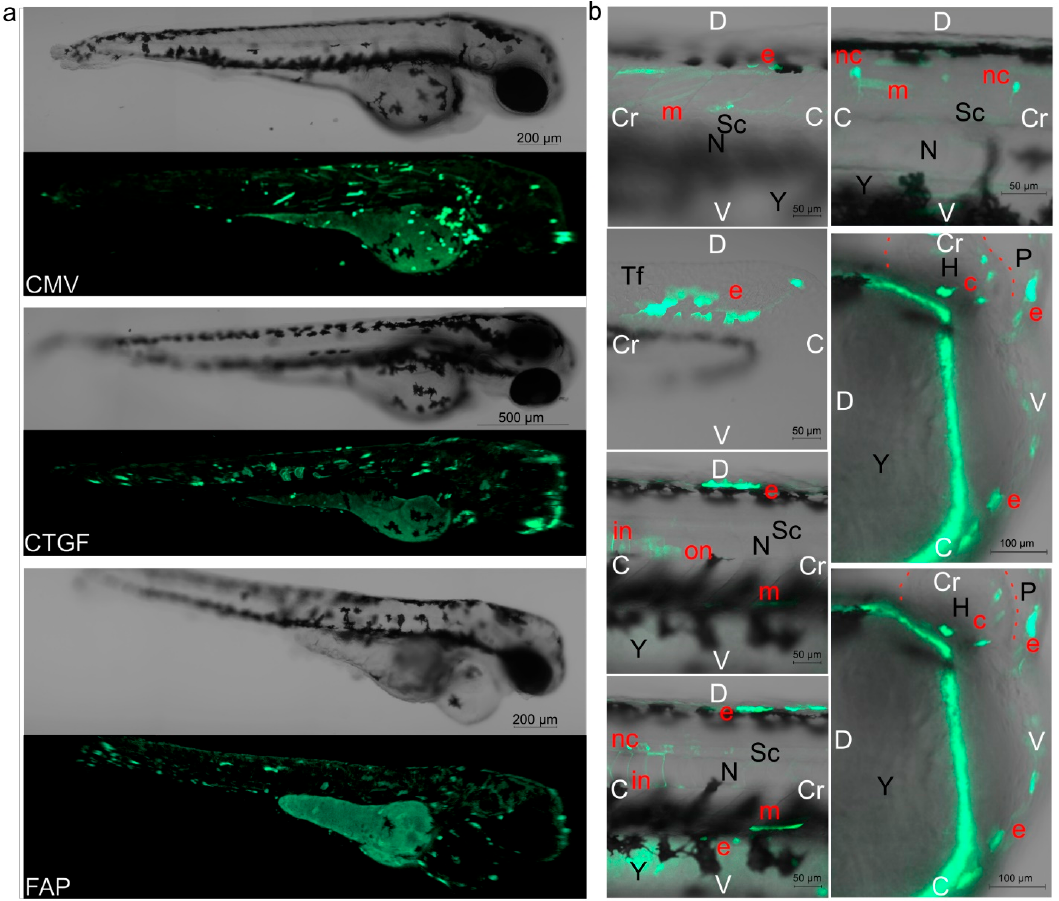
Figure 2. EGFP fluorescence in embryos, 72 h after injection. ( a ) Distribution of EGFP+ fluorescence in embryos injected with 30 attomoles of pGL3(CMV-EGFP), pGL3(CTGF-EGFP), or pGL3(FAP- EGFP). The images shown are obtained by overlaying photographs while scanning along the Z-axis. ( b ) Photographs of individual EGFP+ cells from various body parts of several embryos after injection of 30 amole pGL3(CMV-EGFP). Detailed imaging of labeled embryonic cells using FAP and CTGF promoters in vectors is not shown. White marks: Cr—cravial pole, C—caudal pole, D—dorsal pole, V—ventral pole. Black marks: N—notochord, P—pericardium, Y—yolk sac, Tf—tail fin, H—heart, Sc—spinal cord. Red marks: e—epithelial cells, m—myocytes, nc—cells of the nervous system, c—cardiomyocytes, on—cells of the outer notochord sheath, in—cells of the inner notochord sheath. Cardiomyocytes and blood cells were identi fi ed by their motility during the microscopic analysis. In ( b ), the image of the heart in a state of relaxation and contraction is shown (red do tt ed contours of the location), muscle cells change their position. Blood cells were evaluated and calcu- lated directly during the analysis.